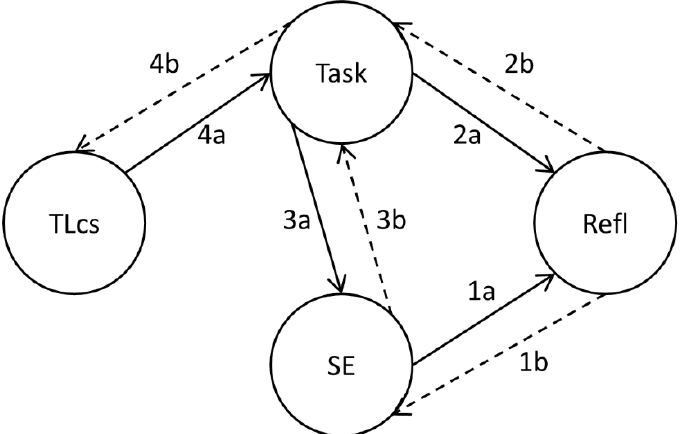
Figure 1. Theoretical framework of how self-reflection (Refl) is influenced by self-efficacy (SE), perceived task interdependence (Task) and the transformational leadership practices individualized consideration and intellectual support (TLcs; solid arrows), as well as the reciprocal relations that will be explored (dashed arrows). The numbers 1a–4b represent the